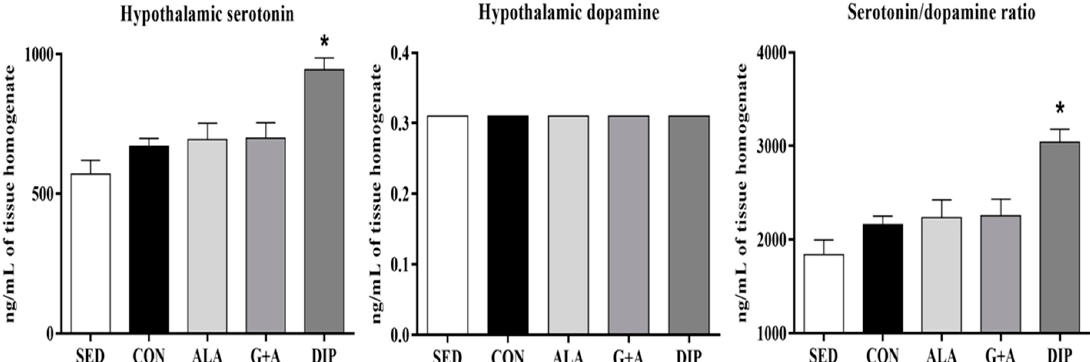
Figure 4. Hypothalamic serotonin, dopamine, and serotonin/dopamine ratio of rats submitted to resistance training and supplementation with L -glutamine and L -alanine. SED: sedentary group, CON: trained group, ALA: trained and supplemented with alanine, G + A: trained and supplemented with glutamine and alanine in their free form, and DIP: trained and supplemented with L -alanyl- L -glutamine. * p < 0.05 vs. SED and CON. Data are presented as mean ± SD.